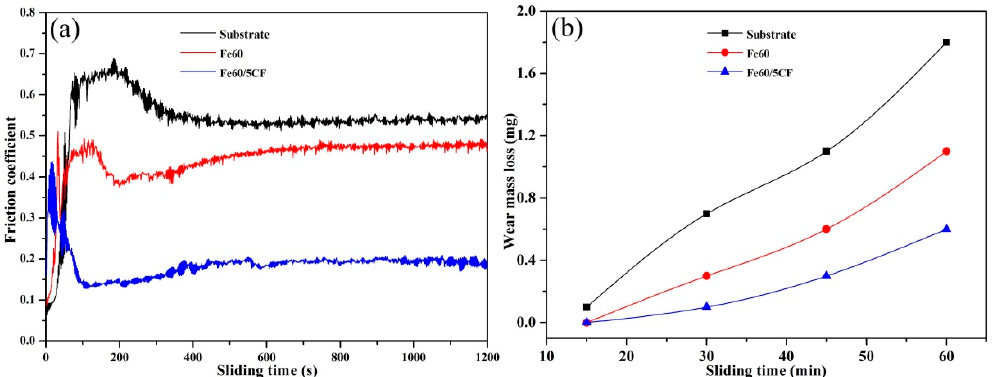
Figure 13. Variations of friction coefficient ( a ) and wear mass loss ( b ) of Fe-based composite coatings as a function of time.